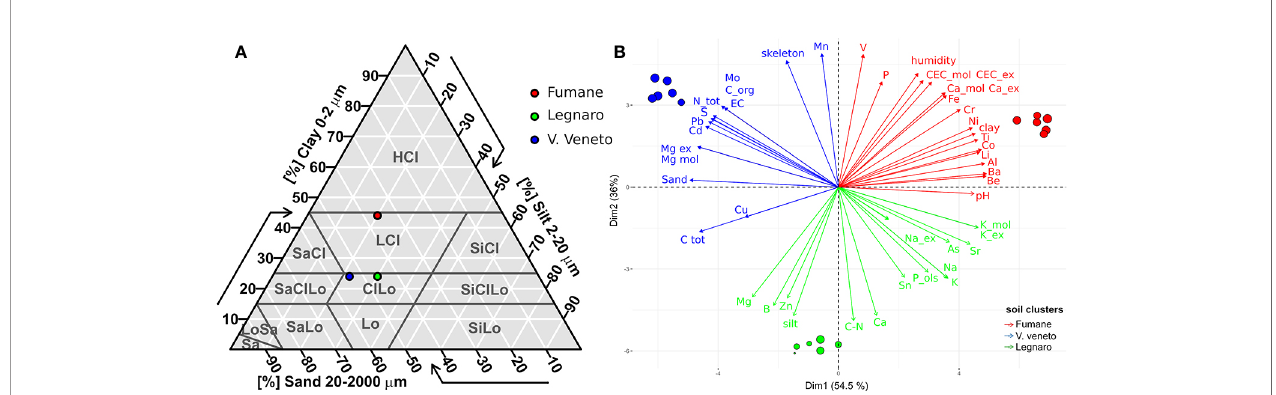
FIGURE 2 | (A) Texture triangle according to the IUSS (International Union of Soil Science). Soils were classi fi ed based on the percentages of sand, silt, and clay. CiLO, clay loam; HCl, heavy clay. (B) Principal component analysis (PCA) and biplot between PC1 (Dim1) and PC2 (Dim2) showing the contribution of 48 physico- chemical parameters (including microelements, macroelements, and exchangeable cations) in explaining the variability of the graphical disposition of the three soils under study. Each colored point represents a soil replicate (n = 6). Red points refer to Fumane soil (F), blue points to Vittorio Veneto (VV), and green points indicate Legnaro soils